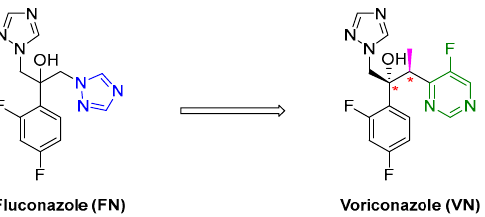
Figure 1. Second-generation triazole drug VN , derived from FN .